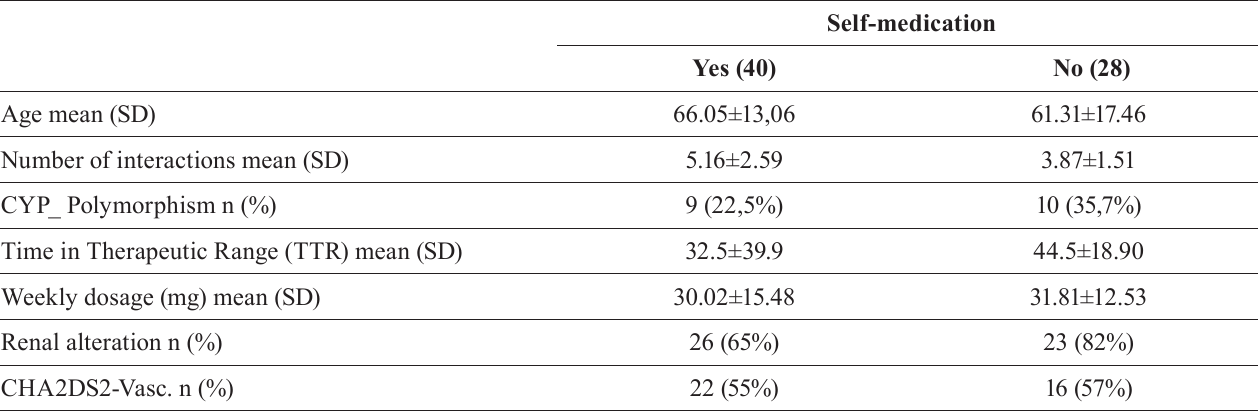
TABLE I - C haracteristics of exposure groups of interest. Ijuí/Brazil